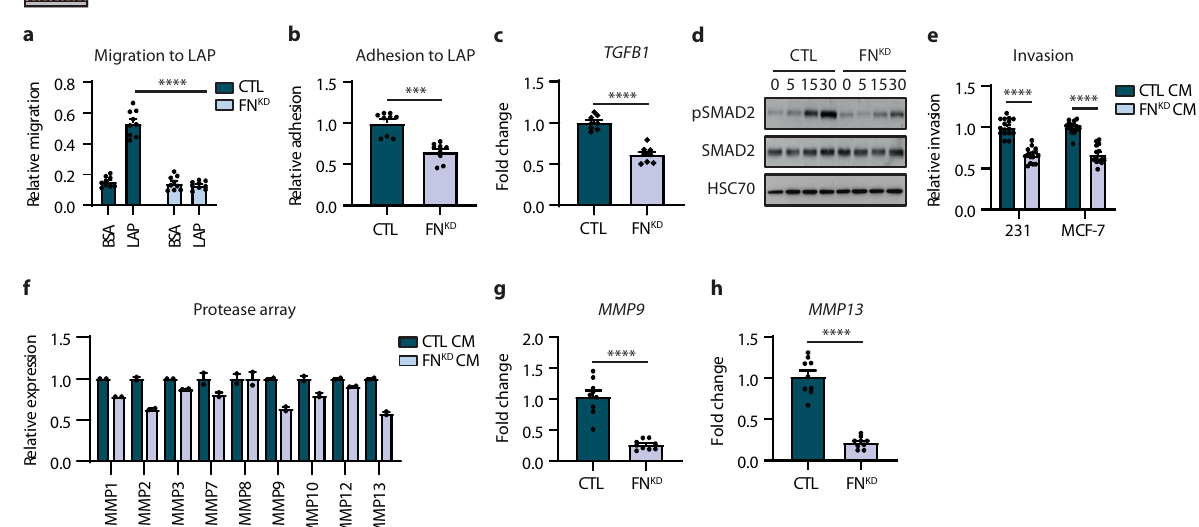
Fig. 3 Integrin β 6-positive myoepithelial cells promote breast cancer cell invasion by fi bronectin-mediated activation of TGF β signalling. a Migration assay for myoepithelial cell line; β 6-1089 transfected with a control (CTL) or fi bronectin-targeted (FN KD ) siRNA, to BSA and LAP (error bars, + s.e.m). n = 3 biological replicates, 3 technical replicates; **** P < 0.0001 (two-tailed t -test). b Adhesion assay for myoepithelial cell lines generated as in ( a ) to LAP (error bars, + s.e.m). n = 3 biological replicates, 3 technical replicates; *** P = 0.0001 (two-tailed t -test). c Bar graph showing qRT-PCR analysis for TGFB1 using RNA isolated from myoepithelial cell lines generated as in ( a ). n = 3 biological replicates, 3 technical replicates; **** P < 0.0001 (two-tailed t -test). d Immunoblots of phospho-SMAD2 (pSMAD2) and SMAD2 in myoepithelial cell lines generated as in ( a ), and stimulated with 5 ng/mL TGF β (time in min). HSC70 serves as loading control. Images are representative of three experiments. e Invasion assay for MDA-MB-231 (231) and MCF-7 cells using conditioned media (CM) isolated from myoepithelial cell lines generated as in ( a ) (error bars, + s.e.m). n = 3 biological replicates, 4-6 technical replicates; **** P < 0.0001 (two-tailed t -test). f Array analysis for pro t eases using conditioned media isolated from myoepithelial cell lines generated as in ( a ) (error bars, + s.e.m). n = 1 biological replicate, 2 technical replicates. g , h Bar graphs showing qRT-PCR analysis for MMP9 ( g ) and MMP13 ( h ) using RNA isolated from myoepithelial cell lines generated as in ( a ) (error bars, + s.e.m). n = 3 biological replicates, 3 technical replicates; **** P < 0.0001 (two-tailed t